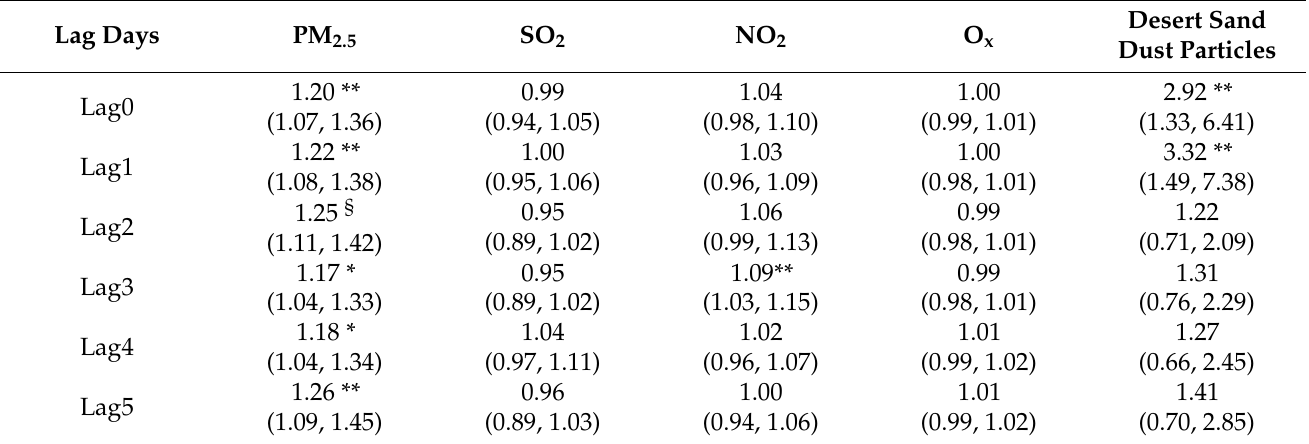
Table 5. Estimated relative risk and 95% confidence interval for absence from school due to fever associated with a 10- µ g/m 3 increase in PM 2.5 , a 1-ppb in NO 2 , SO 2 and O x and a 0.1-km − 1 in desert sand dust particles.